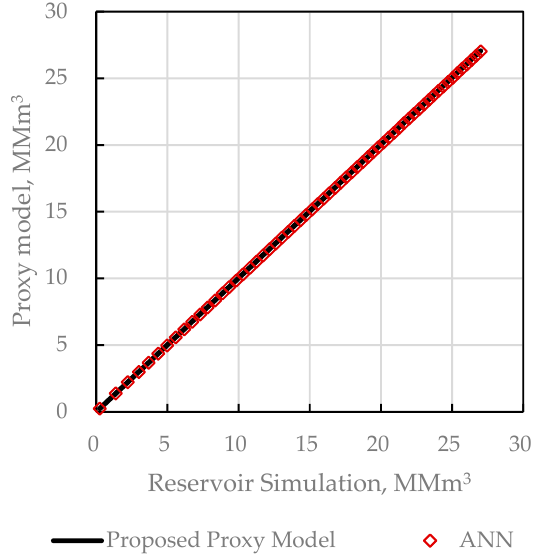
Figure 7. Cross plot of cumulative gas productions at each proxy model.